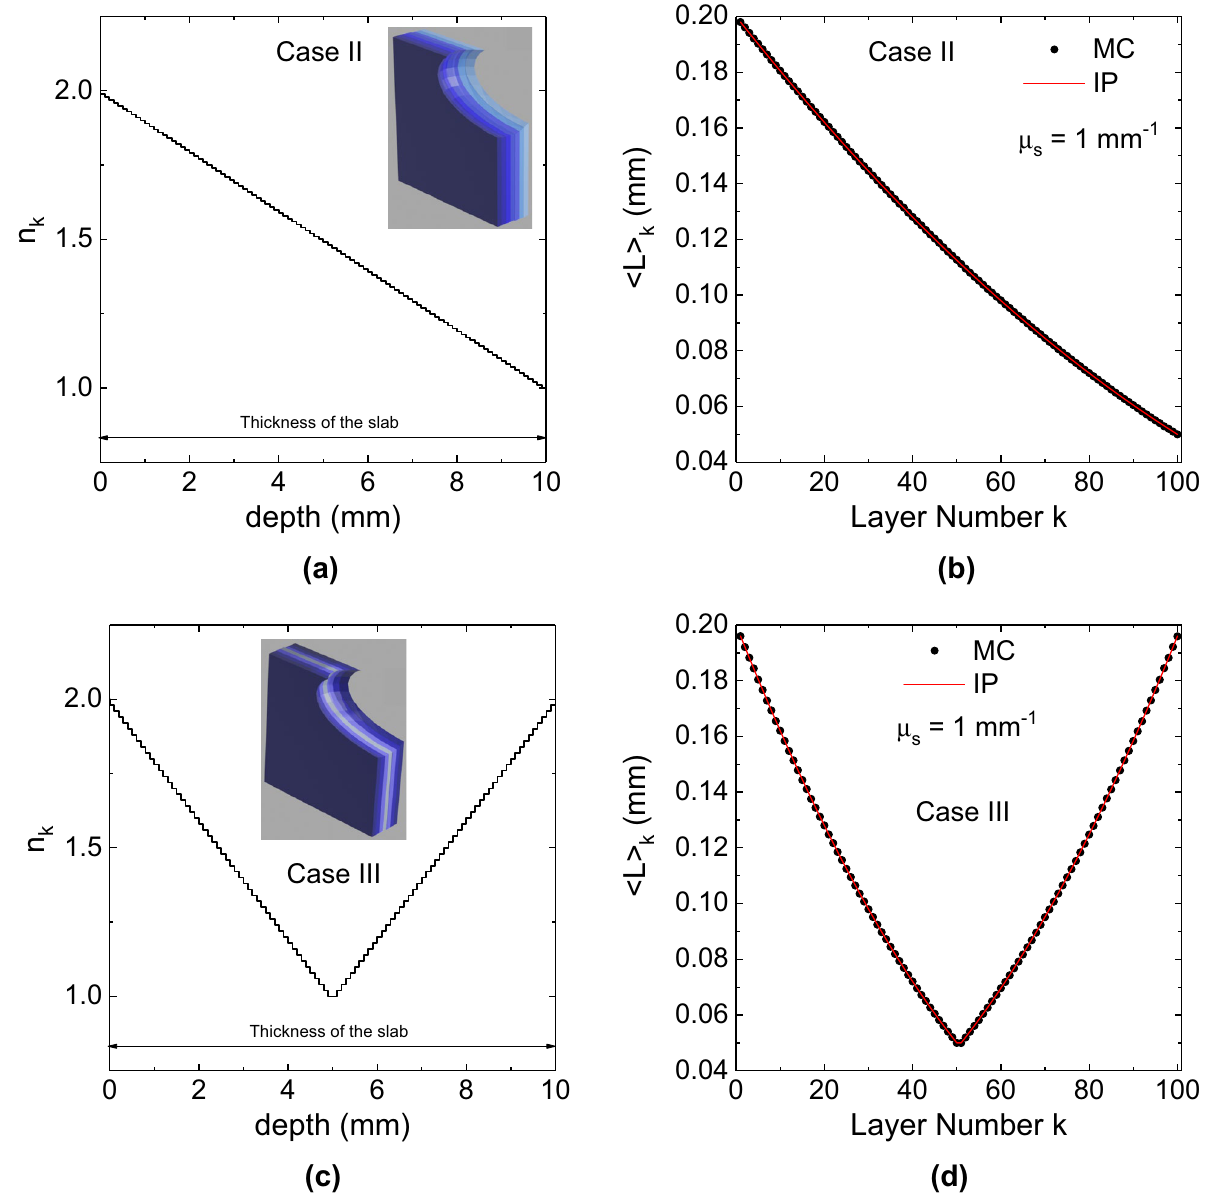
0 ) = L k for a hundred-layered slab for the two distribution (cid:31) (cid:30) 10 7 simulated trajectories. =